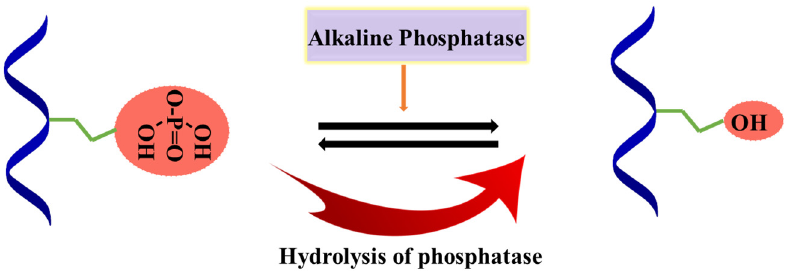
Figure 9. Cleavage of phosphate group from organic phosphate in presence of ALP.